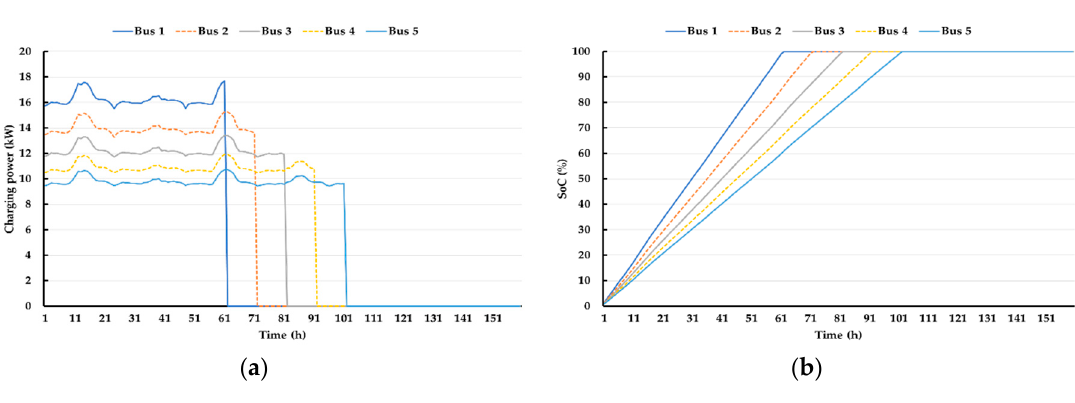
Figure 5. Operational data of the distributed energy storage systems (ESS): ( a ) Charging power; ( b ) state of charge (SoC) profile.